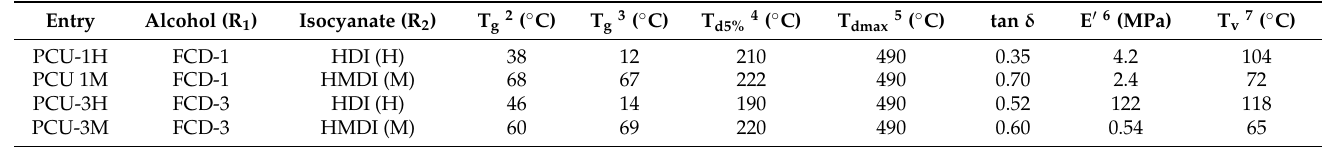
Table 2. Physical properties of synthesized PCUs as different types of alcohol and isocyanate chains 1